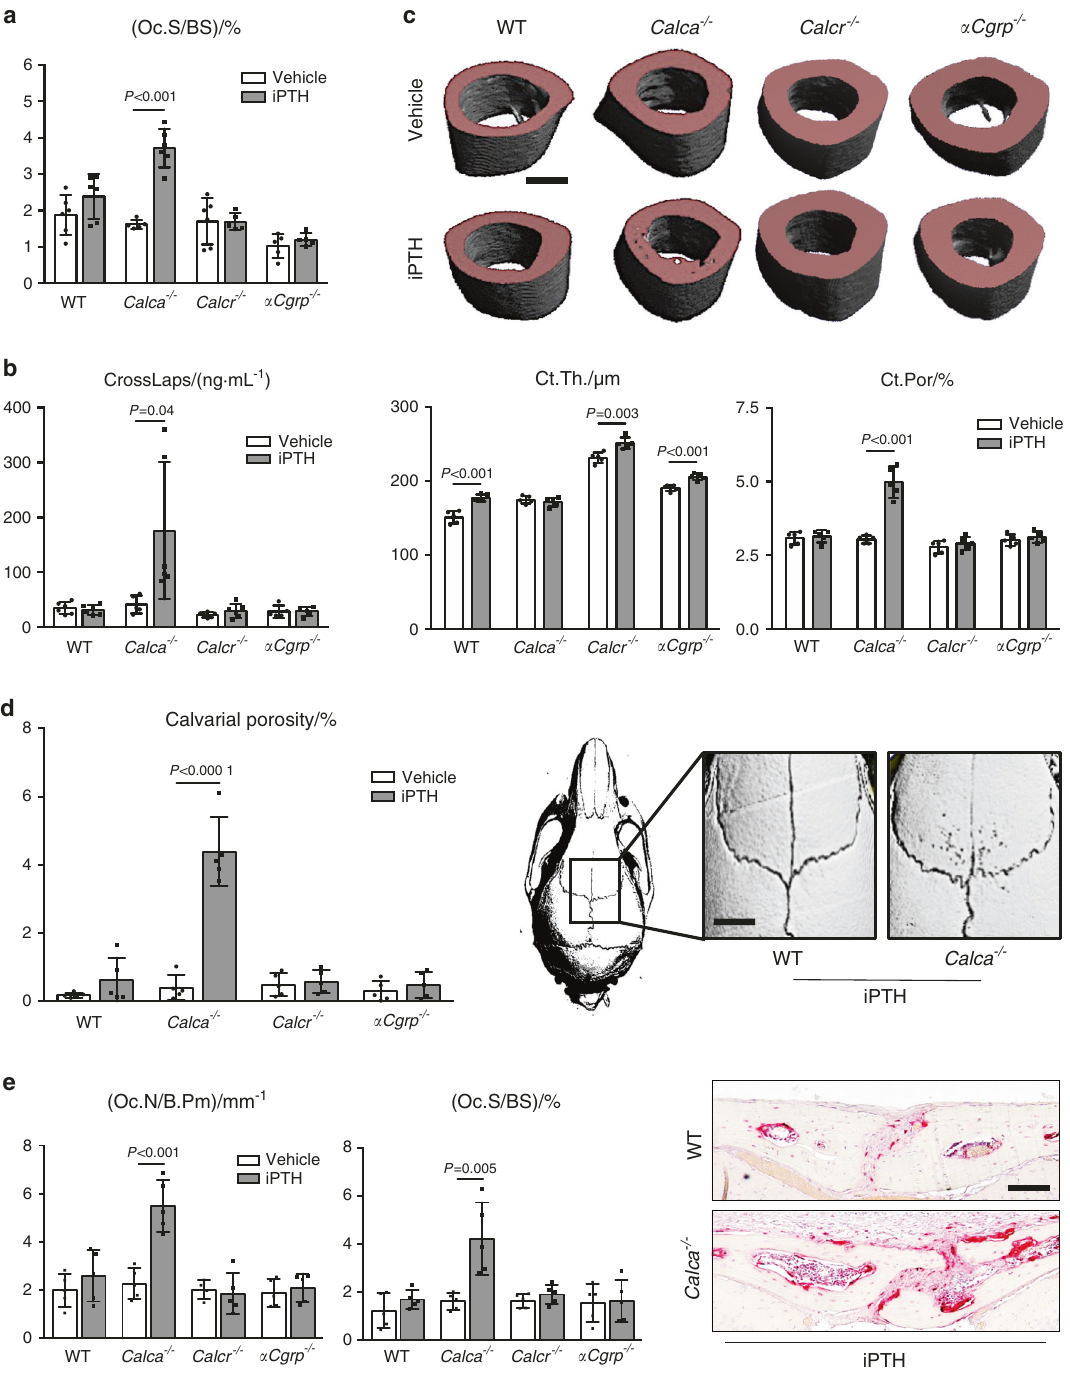
Fig. 4 Excessive bone resorption in mice lacking Calca in response to iPTH. a Quanti fi cation of the osteoclast surface per bone surface (Oc.S/ BS) in trabecular bone of spine samples derived from the indicated groups following 4 weeks of treatment with iPTH (100 μ g·kg − 1 ) or vehicle. b Serum levels of the bone resorption marker beta-CrossLaps (CrossLaps) in the same mice. c Representative μ CT images of humeri with quanti fi cation of cortical thickness (Ct.Th.) and cortical porosity (Ct.Por) in the same mice four weeks after iPTH treatment (scale bar = 400 μ m). d Quanti fi cation of calvarial porosity in the same mice. Representative μ CT images are shown on the right (scale bar = 500 μ m). e Quanti fi cation of the number of osteoclasts per bone perimeter (Oc.N/B.Pm) and osteoclast surface per bone surface (Oc.S/BS) in calvaria of the same mice. Representative TRAP staining images are shown on the right (scale bar = 100 μ m). In ( a – e ), n = 4 – 6 mice per group as indicated (one-way ANOVA followed by Tukey ’ s post hoc increased the expression of Tnfsf11 (encoding the proresorptive extracellular matrix mineralization when treated with ProCT. protein RANKL) in WT cells (Fig. 5e). Together, these fi ndings ruled Moreover, stimulation of WT and Calca -de fi cient osteoblasts with out the possibility that ProCT inhibits bone resorption through its ProCT did not alter the expression of key osteoblast differentia- action on osteoblasts. tion markers (Fig. 5d) and, unexpectedly, even signi fi cantly